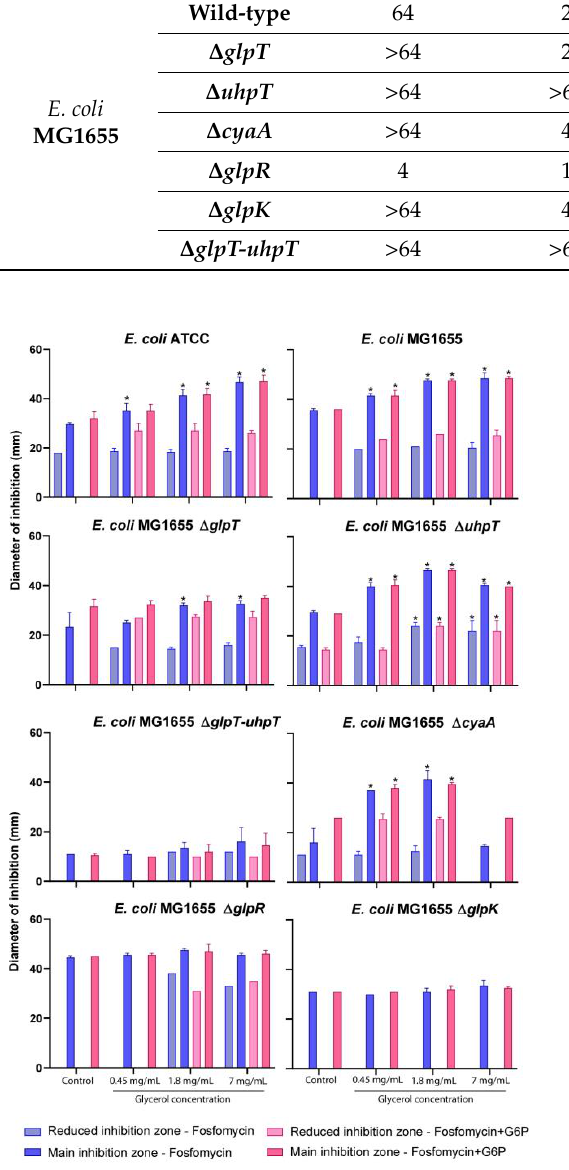
Figure 3. Results of fosfomycin susceptibility by disk diffusion assay with the addition of 0.45, 1.8, and 7 mg/L of glycerol and/or 25 mg/L of glucose-6-phosphate (G6P). The dark-colored columns show the diameter of the main inhibition zone (mean, mm), and the light-colored columns show the diameter of the reduced inhibition zone (mean, mm). Error bars represent the standard deviation. * denotes p < 0.05 with respect to their respective control.